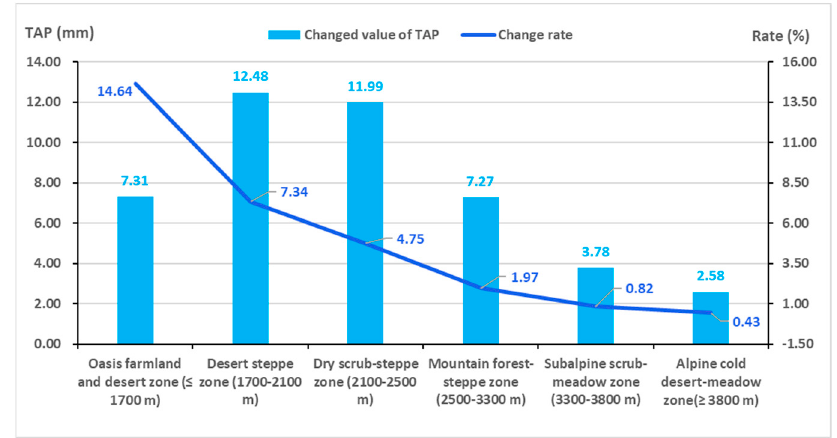
Figure 7. Change trends of TAP in the different elevation zones.